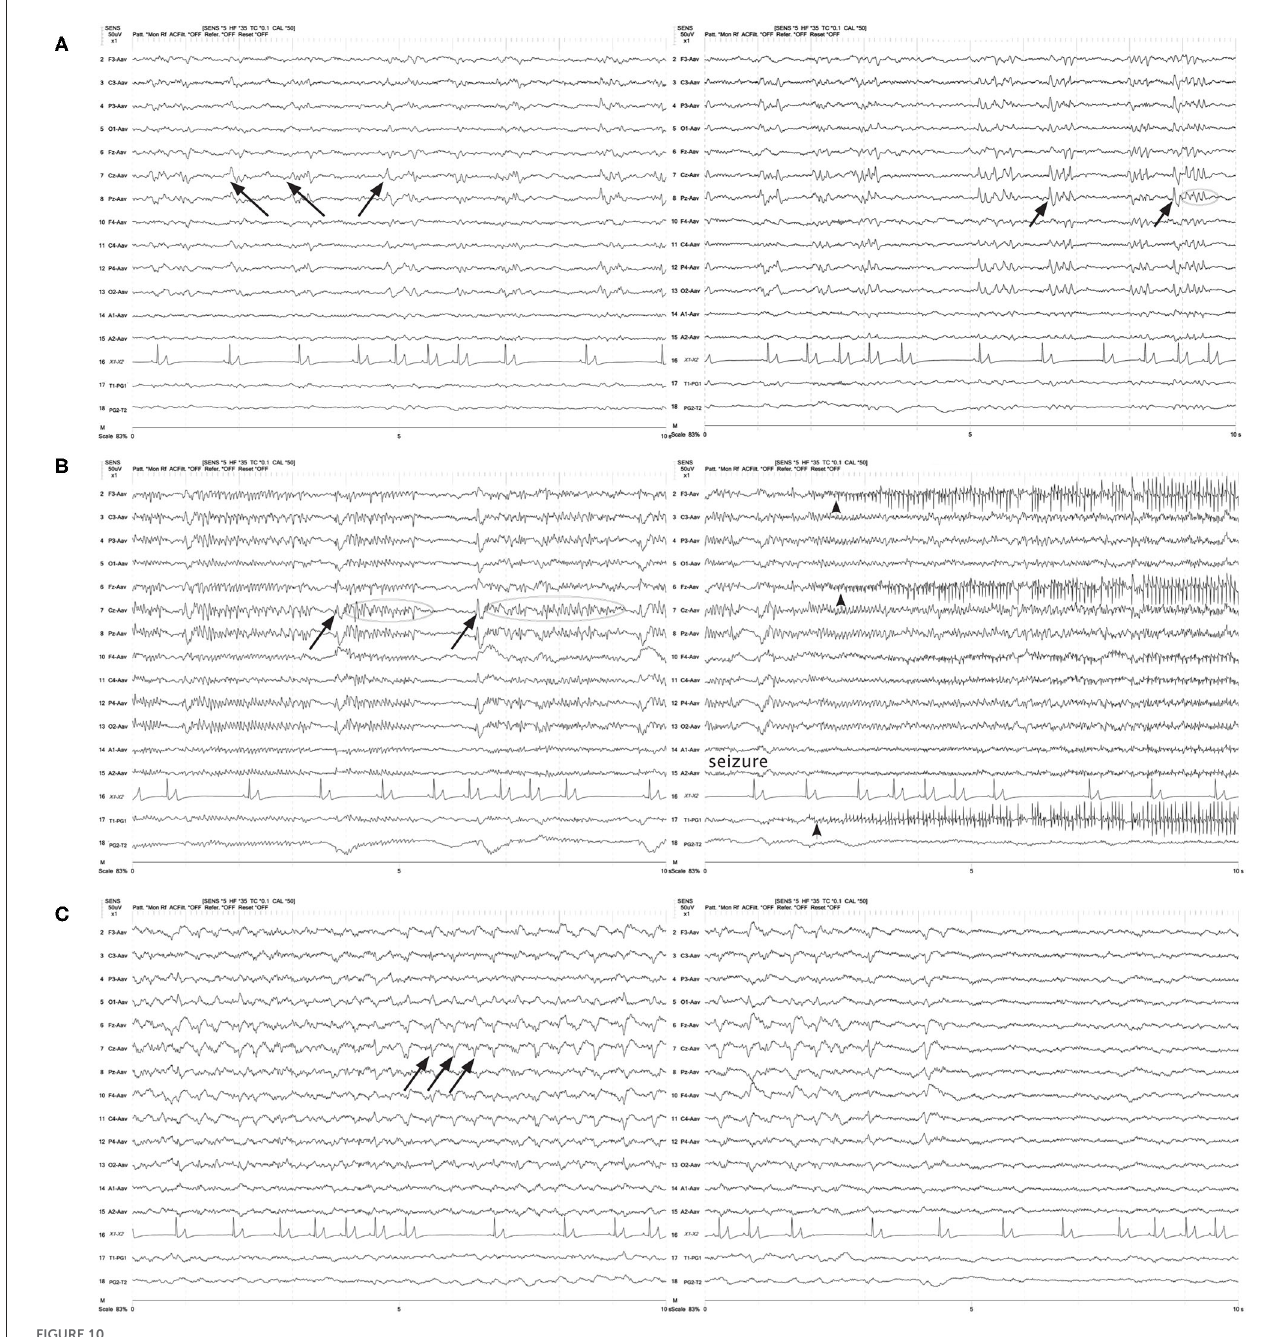
FIGURE10 Three sets of consecutive EEG epochs in a 12 year old Shepherd mix illustrating evolution of GPDs to a focal seizure, and spontaneous resolution. The dog has a history of nasal aspergillosis and recent cluster seizures. Referential montage HF 35Hz, sensitivity 5 uV/mm. (A) GPDs (arrows) progressively become more polyphasic, then develop bursts ( > 4 phases, longer than 500ms) (circle). (B) GPDs (arrows) are associated with progressively longer bursts (circles), until a clinical focal seizure involving the left eye and face occurs, lasting 40s. No pharmacologic intervention was given. Arrowheads indicate the start of electromyography (EMG) artifact from the muscle activity on the left frontal (F3, Fz) and left eye channels. (C) After termination of the clinical seizure, the GPDs (arrows) are apparent at a 2–2.5Hz frequency, until they terminate spontaneously.